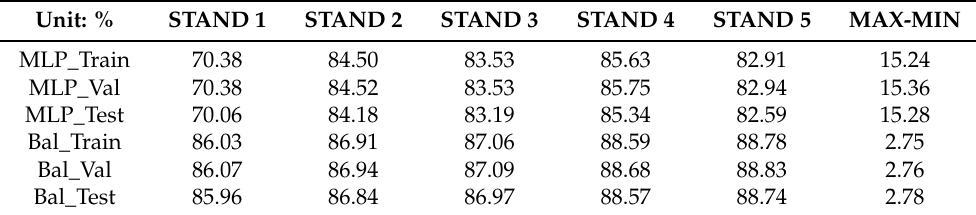
Table 22. Comparison of the usage rates of the motor